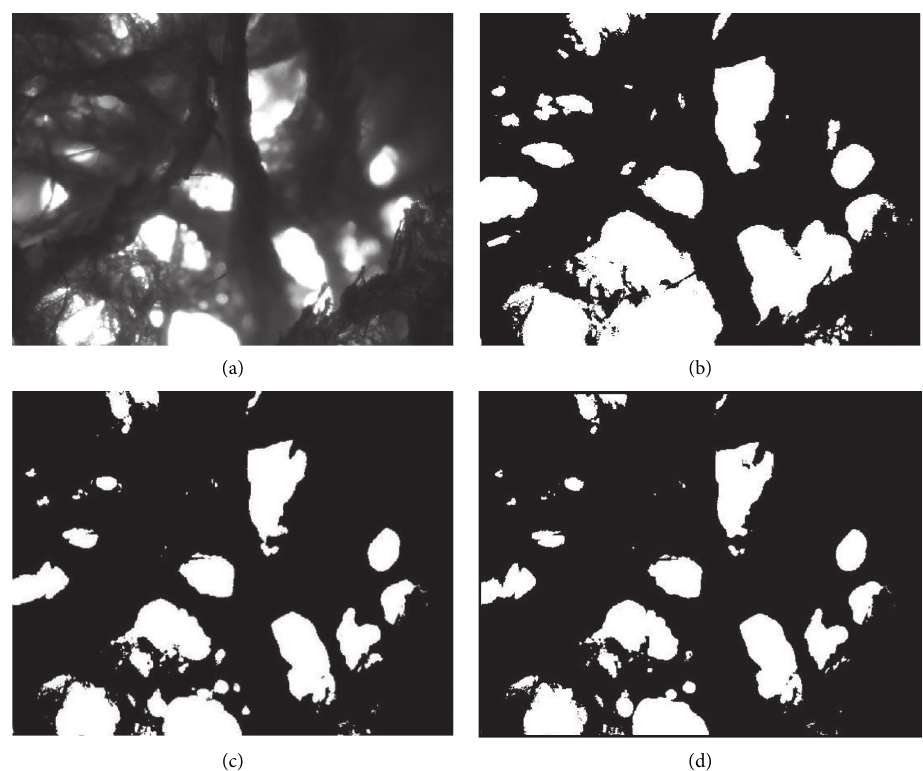
Figure 2: Real images and binary images with different thresholds. (a) Image of ashing processing. The image of the sample at the threshold values of (b) 0.3, (c) 0.4, and (d) 0.5.